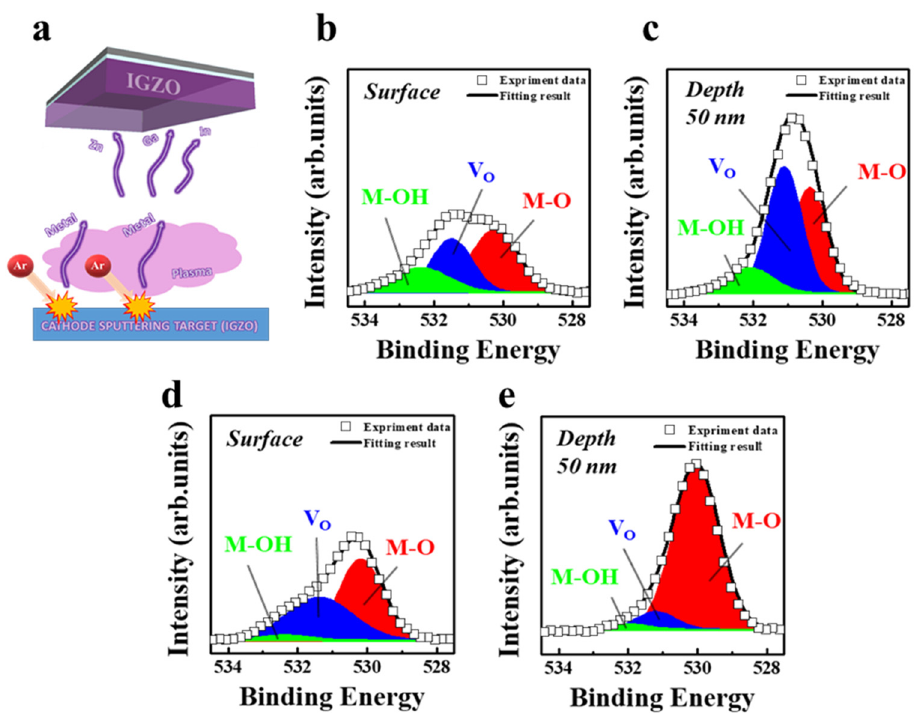
Figure 2. Materials analysis of the proposed IGZO semiconductor utilized in the device. ( a ) A schematic layout of the sputtering process of IGZO channel material. ( b , c ) An XPS analysis of IGZO film before annealing with surface and depth (50 nm) profiling method, respectively. ( d , e ) XPS analysis of IGZO film after annealing with surface and depth (50 nm) profiling method, respectively.